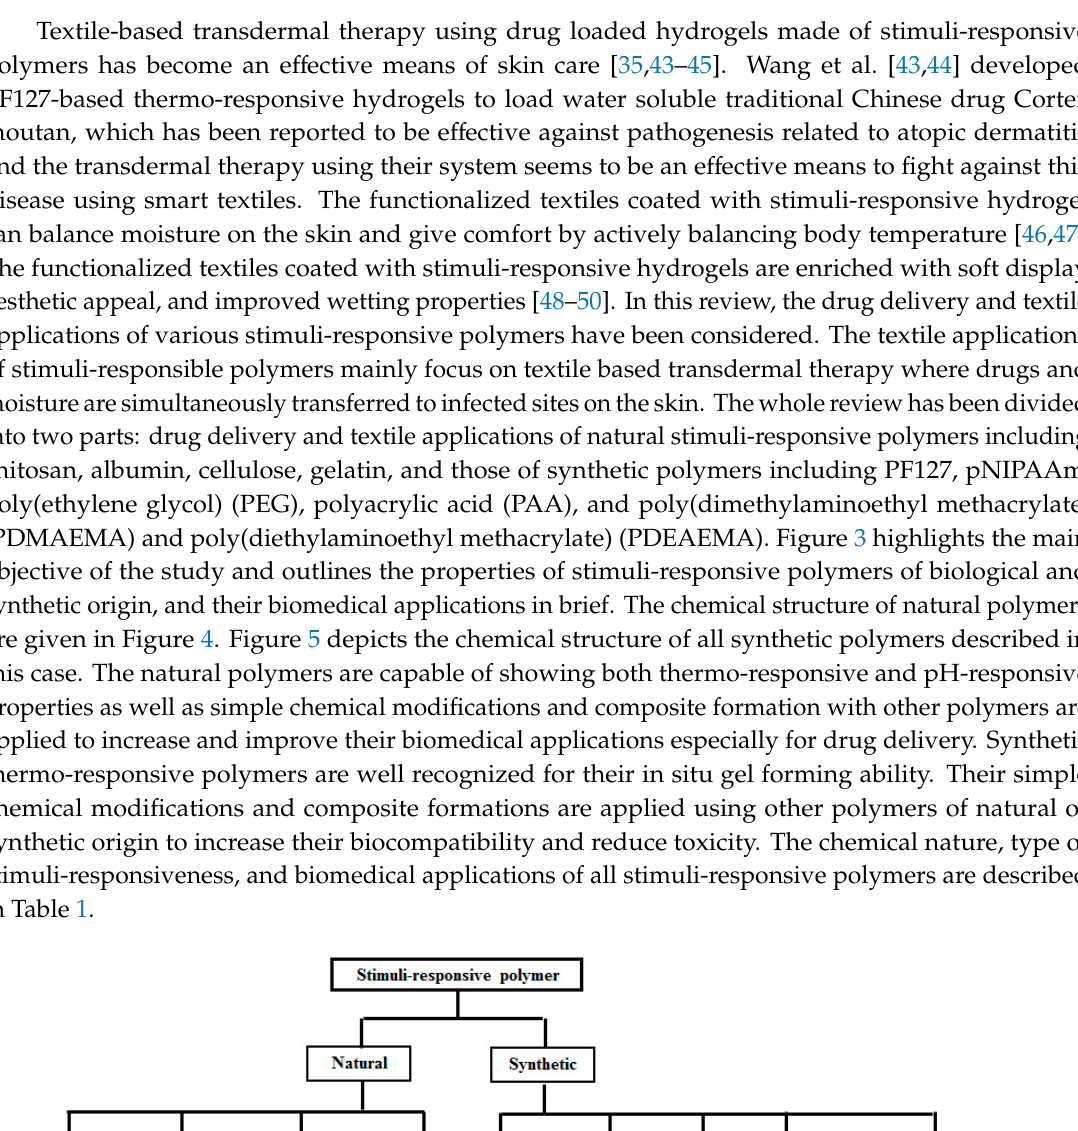
Figure 3. The flowchart outlining the selection of stimuli-responsive polymers and their applications.